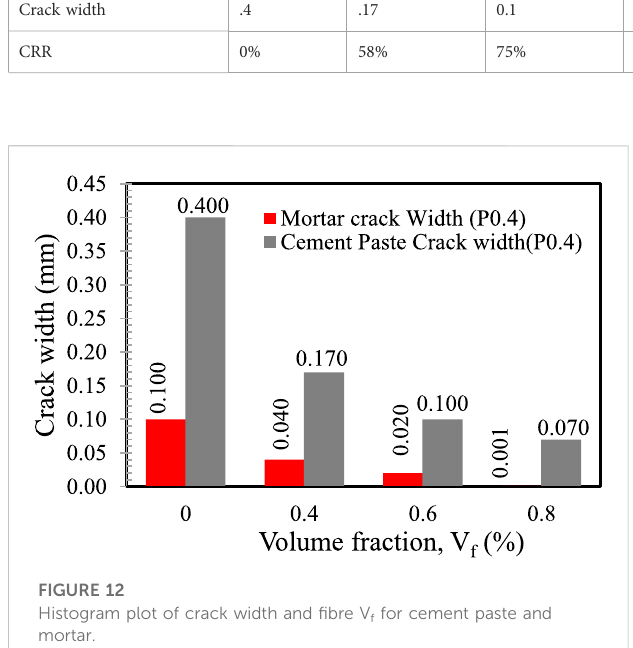
FIGURE 12 Histogram plot of crack width and fi bre V f for cement paste and mortar.